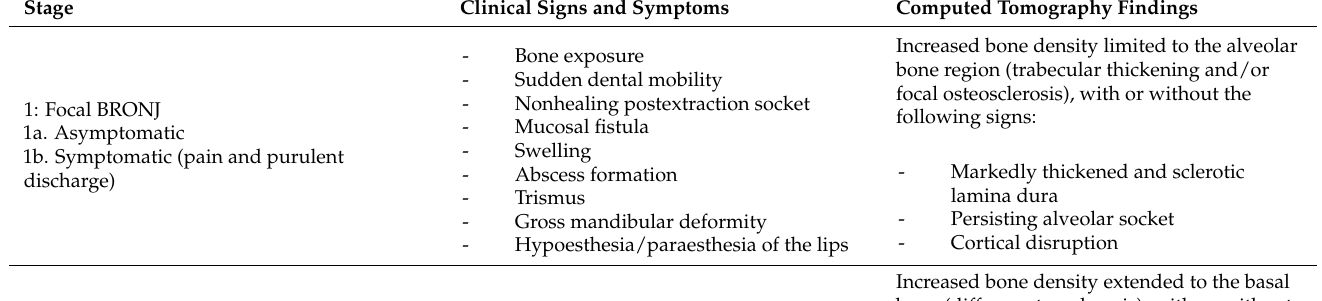
Table 1. Classification of MRONJ by the Italian Societies of Maxillo-facial Surgery (SICMF) and Oral Pathology and Medicine (SIPMO). Stage Clinical Signs and Symptoms Computed Tomography